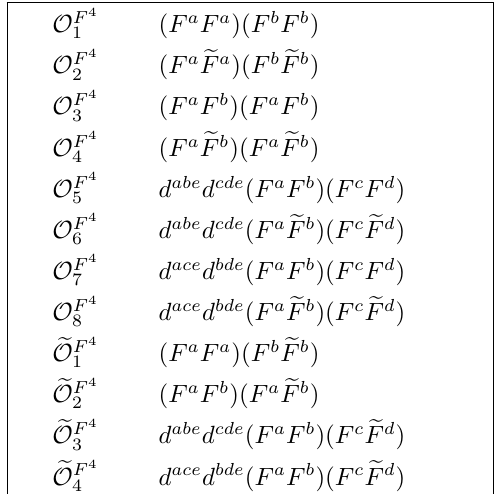
Table 4 . Basis of independent operators for SU( N ) Yang-Mills theory that are quartic in gauge (cid:12)eld strengths. Notation is as in table